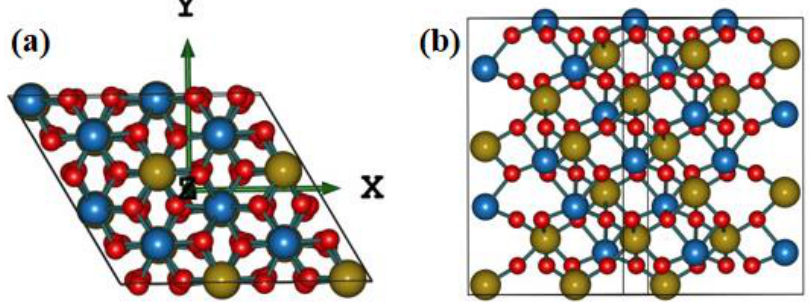
Figure 6. Structures of perfect 001 surface of ZS. Top view ( a ) and side view ( b ).